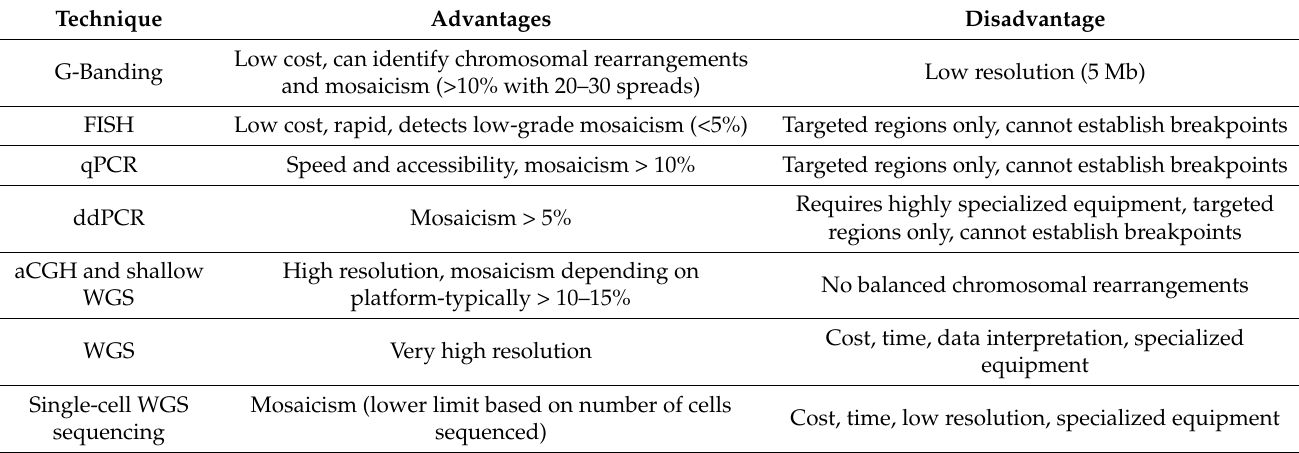
Table 1. Methods for genetic screening of hPSC